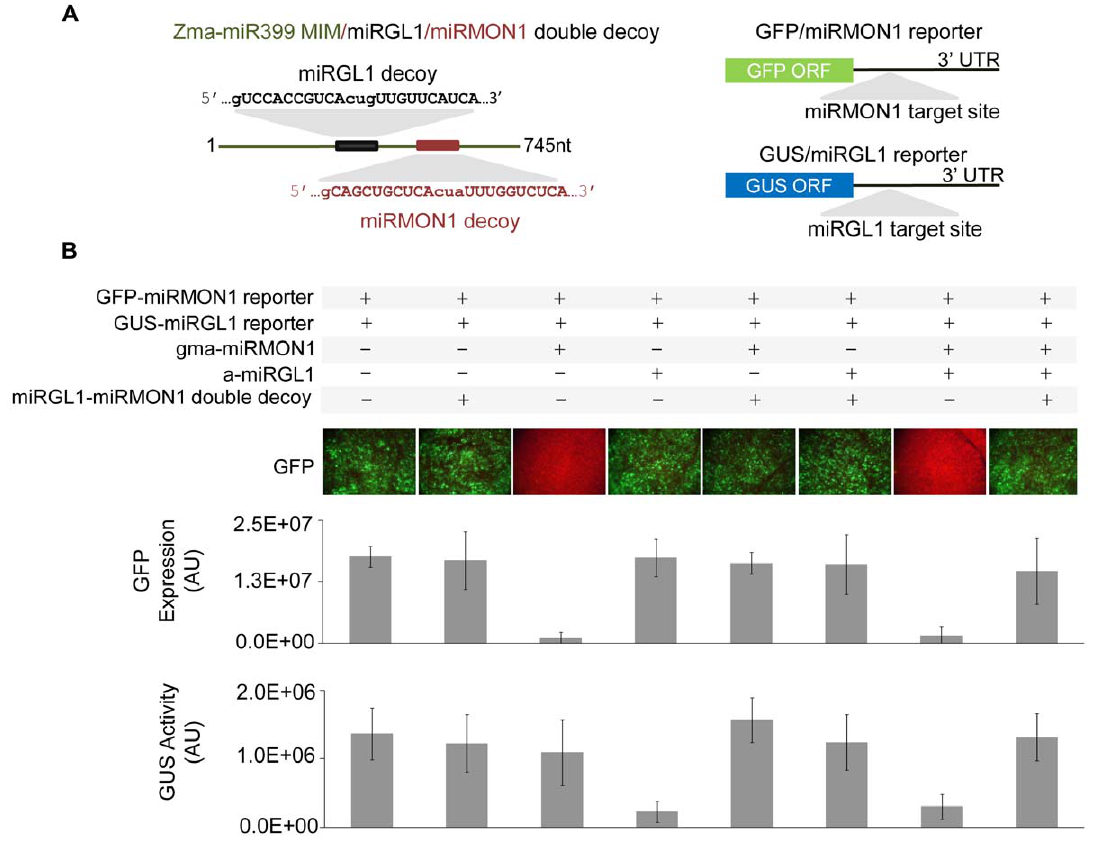
Figure 2. Inactivation of multiple miRNAs using a heteromeric miRNA decoy cassette. ( A ) Diagram of heterodimeric miRNA decoy transcript designed to bind both miRMON1 and a-miRGL1. ( B ) Quantitative analysis of micrographs of miRMON1-targeted GFP reporter intensity and of miRGL1-targeted GUS reporter in N. benthamiana leaves. Leaves were co-transformed with one part GFP and/or one part GUS reporter, 5 parts miRMON1 and/or 5 parts miRGL1, and ten parts miRNA decoy. Agrobacterium transformed with a control vector was added to achieve a total OD 600 =1 of Agrobacterium for each transformation. GFP intensity values are averages of six individual transformations. Tissue from the seven individual transformations per inoculum mix was used to measure GUS activity.